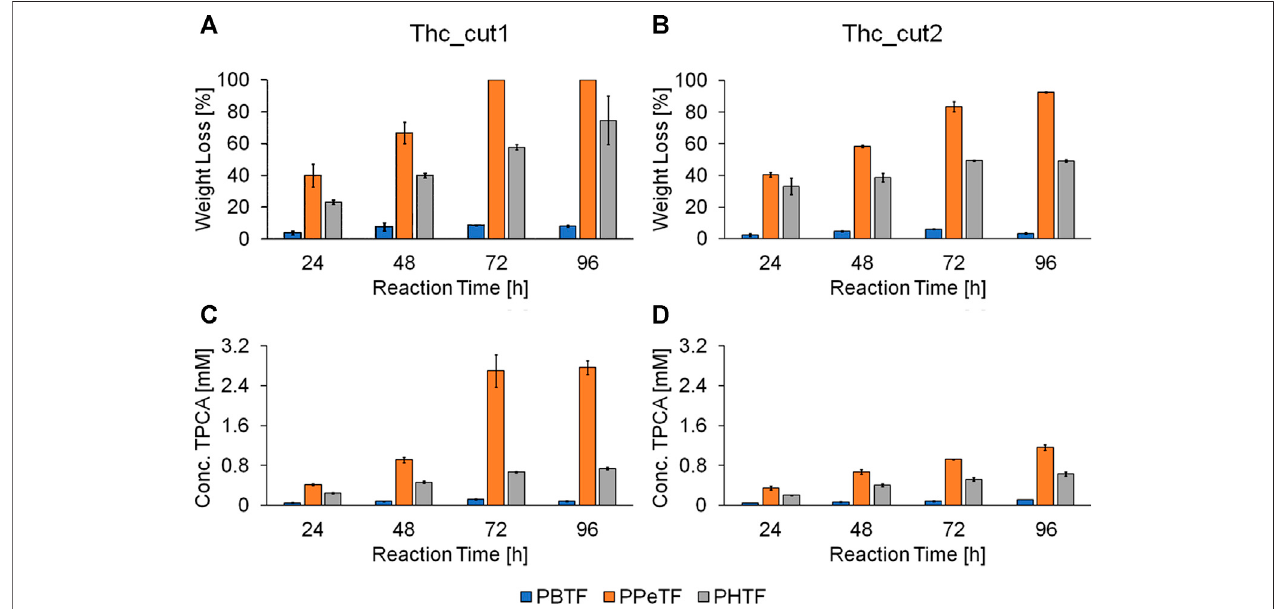
FIGURE 4 | Enzymatic hydrolysis of TPCA-based polyesters. Weight loss (panels A and B ) and HPLC analysis (panels C and D ) of the polyester fi lms treated with Thc_cut1 (panels A , C ) and Thc_cut2 (panels B and D ) using 1 M KH 2 PO 4 /K 2 HPO 4 buffer pH 8.0 at 65 ° C. All experiments were performed in quadruplicate and the average values ± the standard deviations are